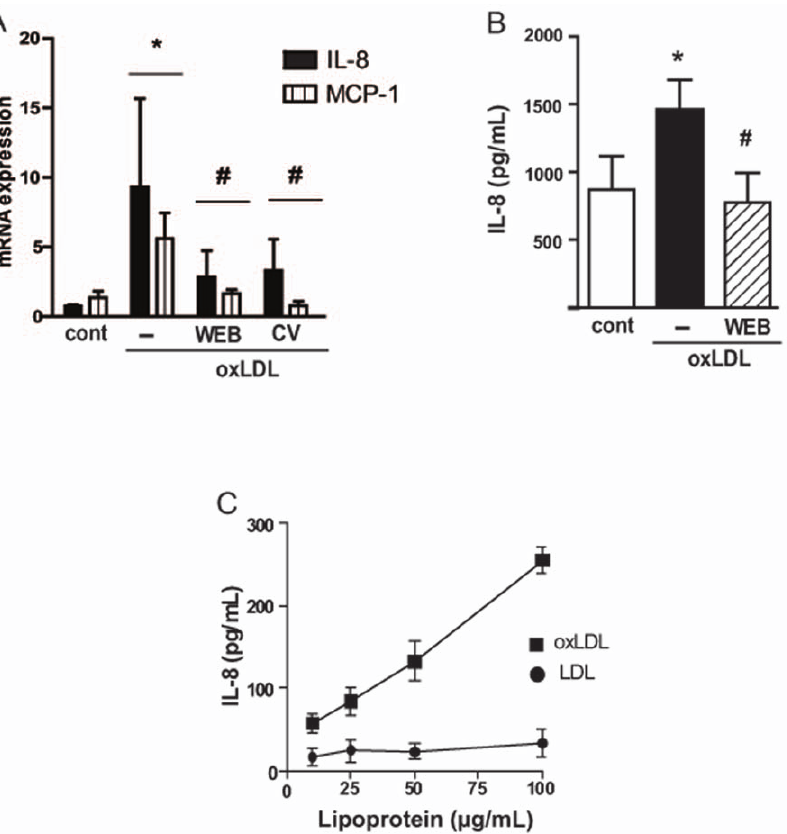
Figure 5. oxLDL induces IL-8 and MCP-1 in a PAFR-dependent manner. Adherent human monocytes/macrophages were treated with WEB2170 (50 m M) or CV3988 (10 m M) for 30 min and stimulated with oxLDL (30 m g/mL). The mRNA levels for MCP-1 and IL-8 were evaluated after 5 h (n=4) (A). The IL-8 concentration was measured in the supernatants after 24 h (n=3) (B). THP-1 cells stimulated with different concentrations of oxLDL or LDL, the IL-8 concentration was measured after 24 h (C). Data are presented as mean 6 SEM. * p , 0.05 comparing oxLDL stimulated with non-stimulated cells (cont). # p , 0.05 comparing cells treated with WEB2170 or CV3988 with non-treated cells.